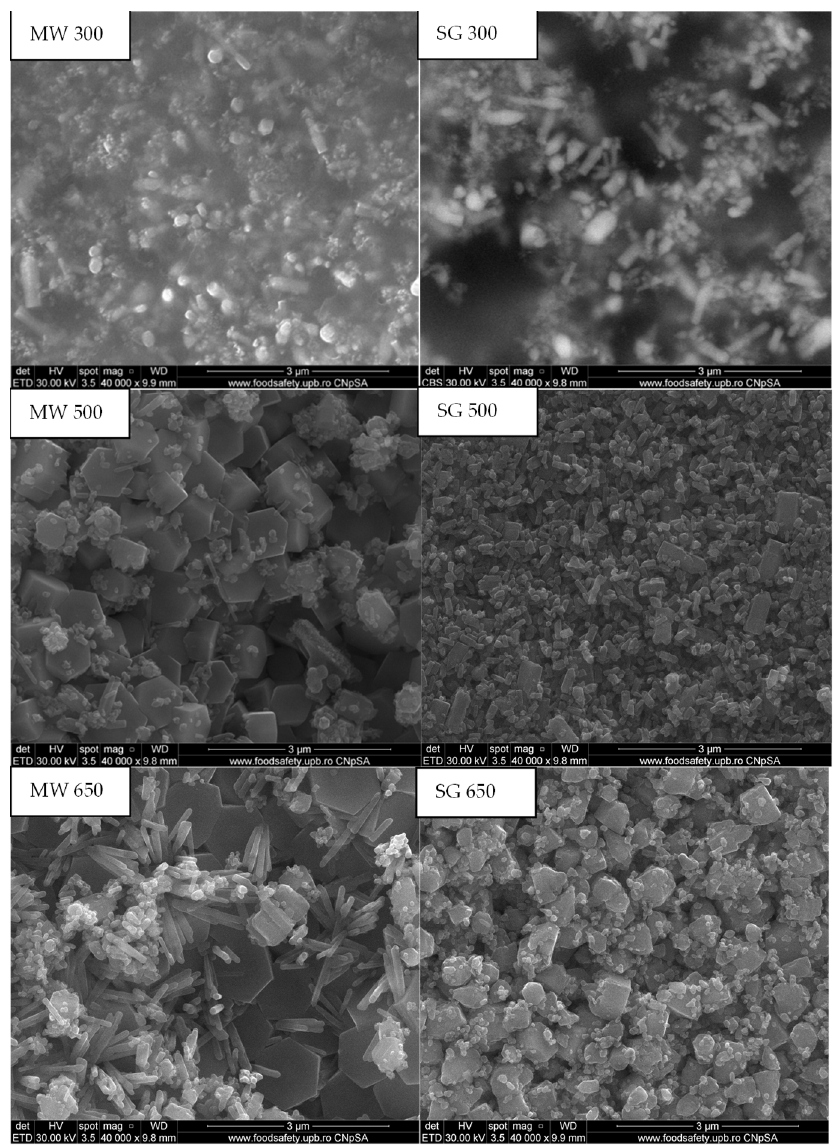
Figure 4. SEM images of the MW and SG powders, thermally treated at 350 °C/1 h, 500 °C/1 h, and 650 °C/1 h.